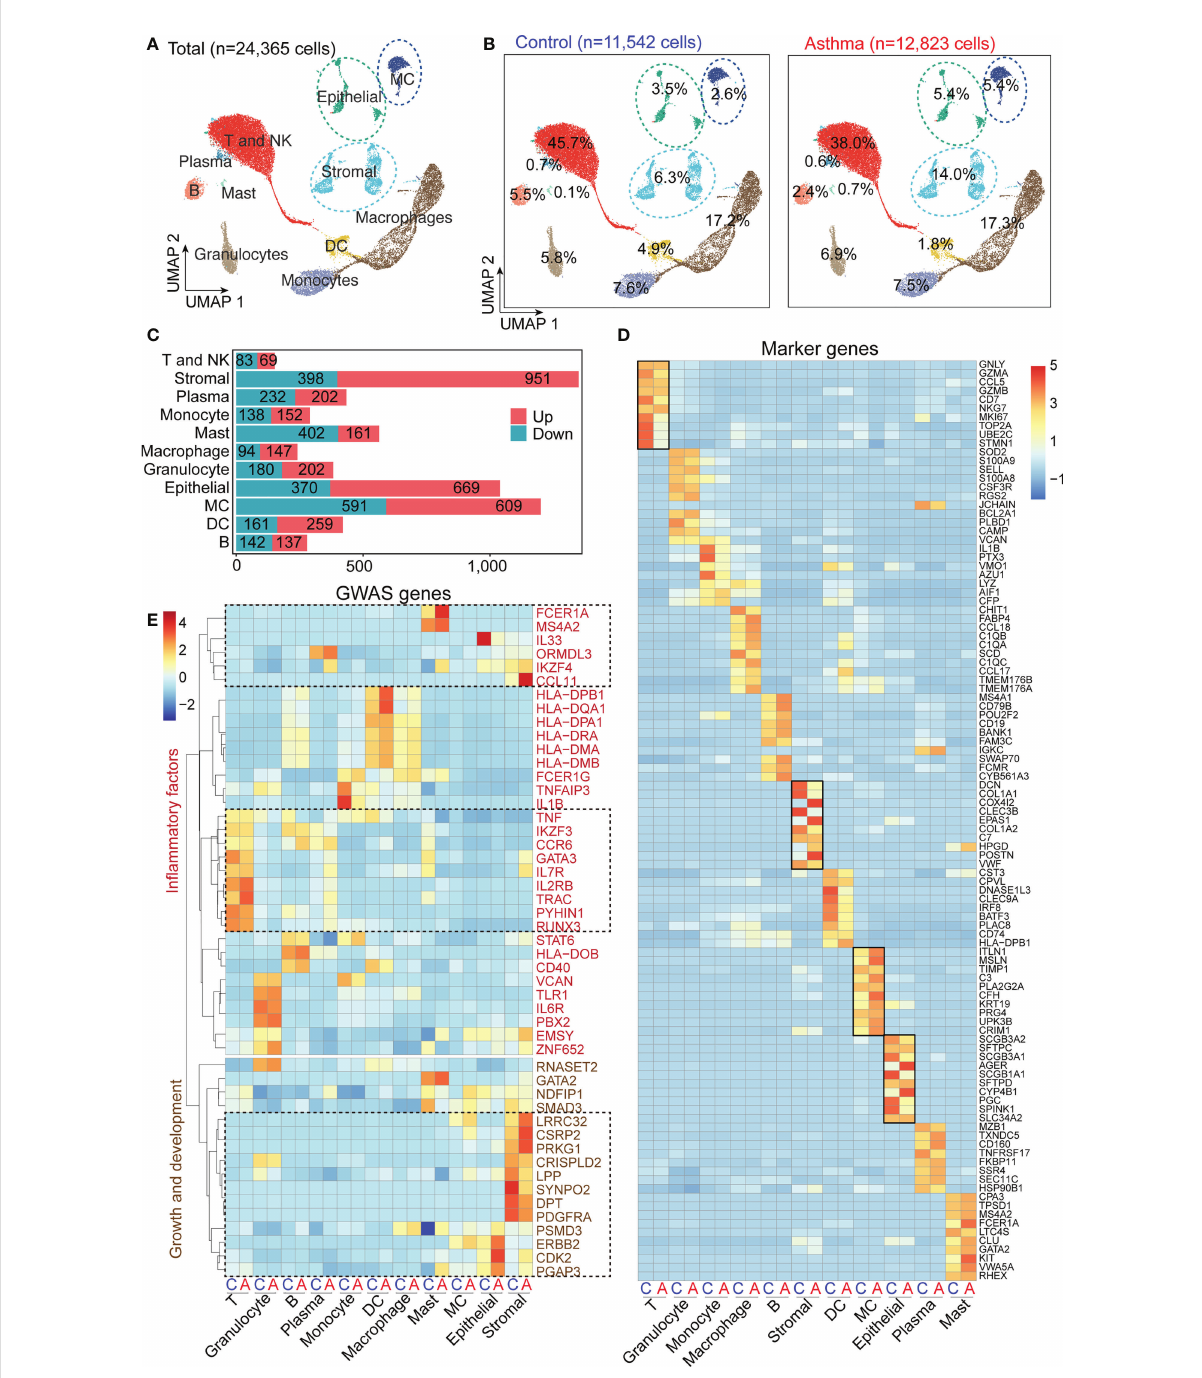
FIGURE 3 A.suum -induced asthma elevates the numbers of stromal and mesenchymal cells and induces various gene expression changes in multiple cell types in cynomolgus monkeys. (A) , UMAP of 24,356 cells from asthma and control lungs colored by 11 major cell types based on signature gene expression. (B) , UMAP displaying the proportions of cell subsets in the control and asthma group. (C) , DEG numbers of control and asthma in 11 major cell types. (D) , Heatmap depicting the average expression levels per cluster of the top 10 differentially expressed markers in the control and asthma groups. (E) , Heatmap displaying asthma GWAS gene expression per cluster. Only genes enriched in in fl ammation, growth and development are